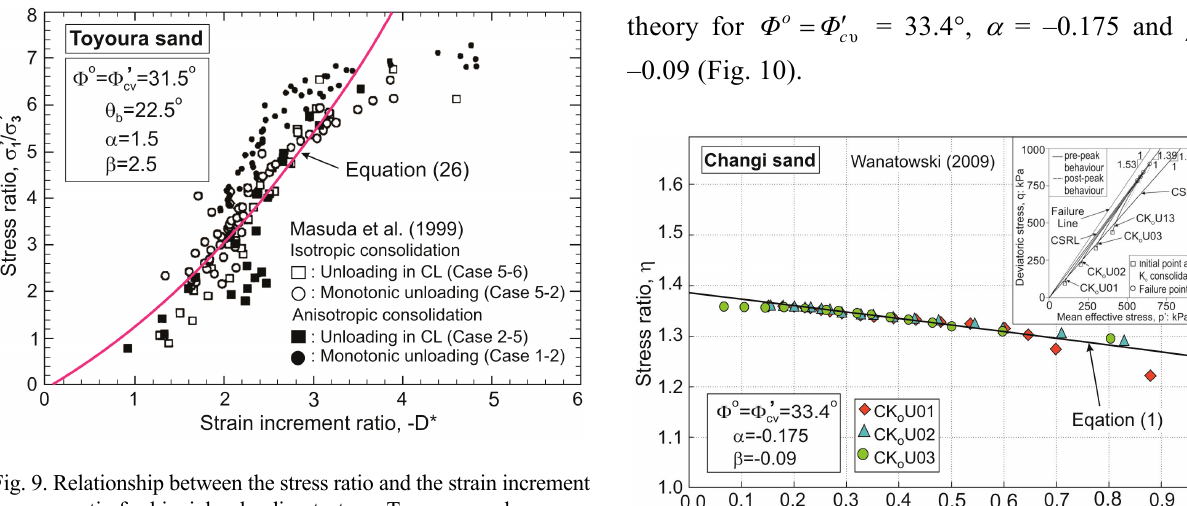
Fig. 9. Relationship between the stress ratio and the strain increment ratio for biaxial unloading tests on Toyoura sand